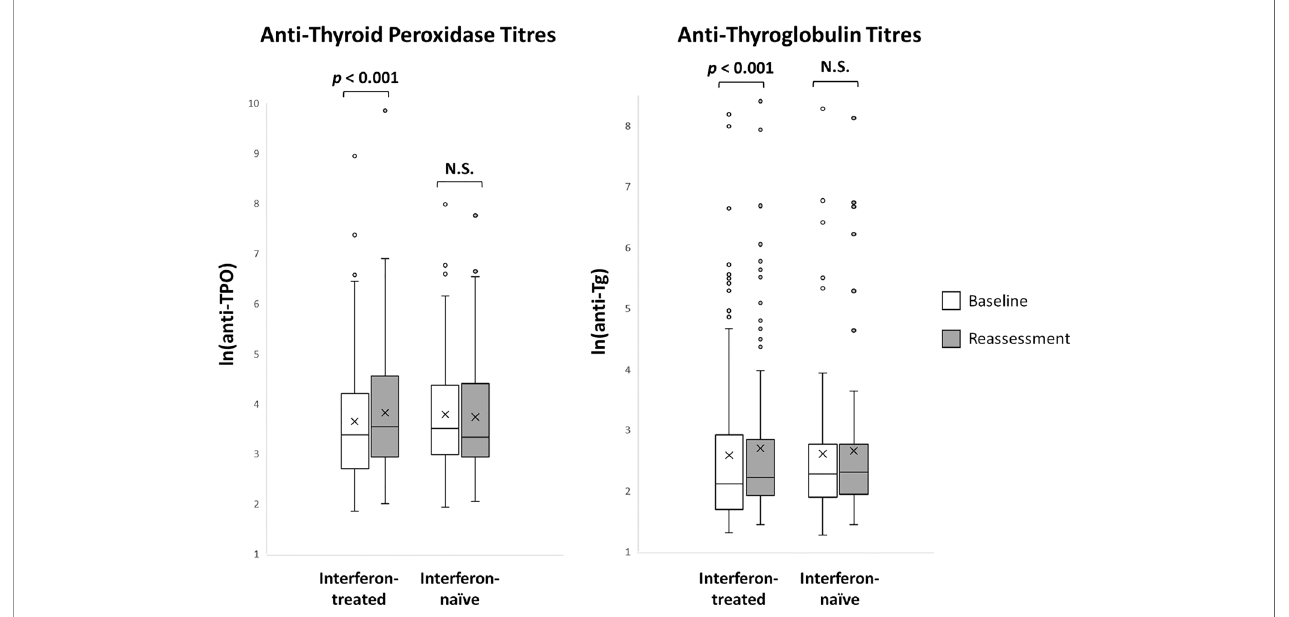
FIGURE 3 | Anti-thyroid antibody titres at baseline and reassessment according to interferon exposure (n = 179). N.S., not signi fi cant.